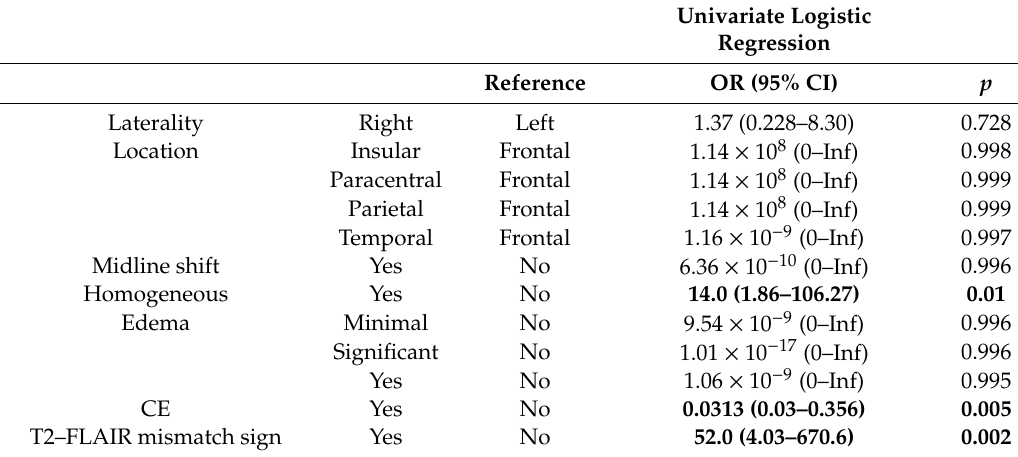
Table 3. Univariate logistic regression. The isocitrate dehydrogenase (IDH) status could be predicted based on the homogeneity, contrast enhancement, and the T2–FLAIR mismatch